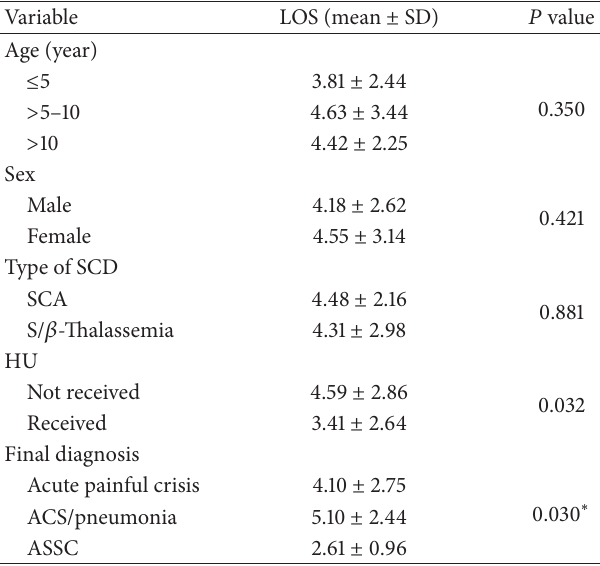
Table 4: Length of hospital stay in relation to selected variables among patients with